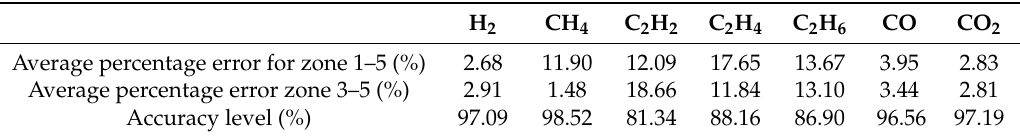
Table 6. Average percentage error and accuracy level for dissolved gases.